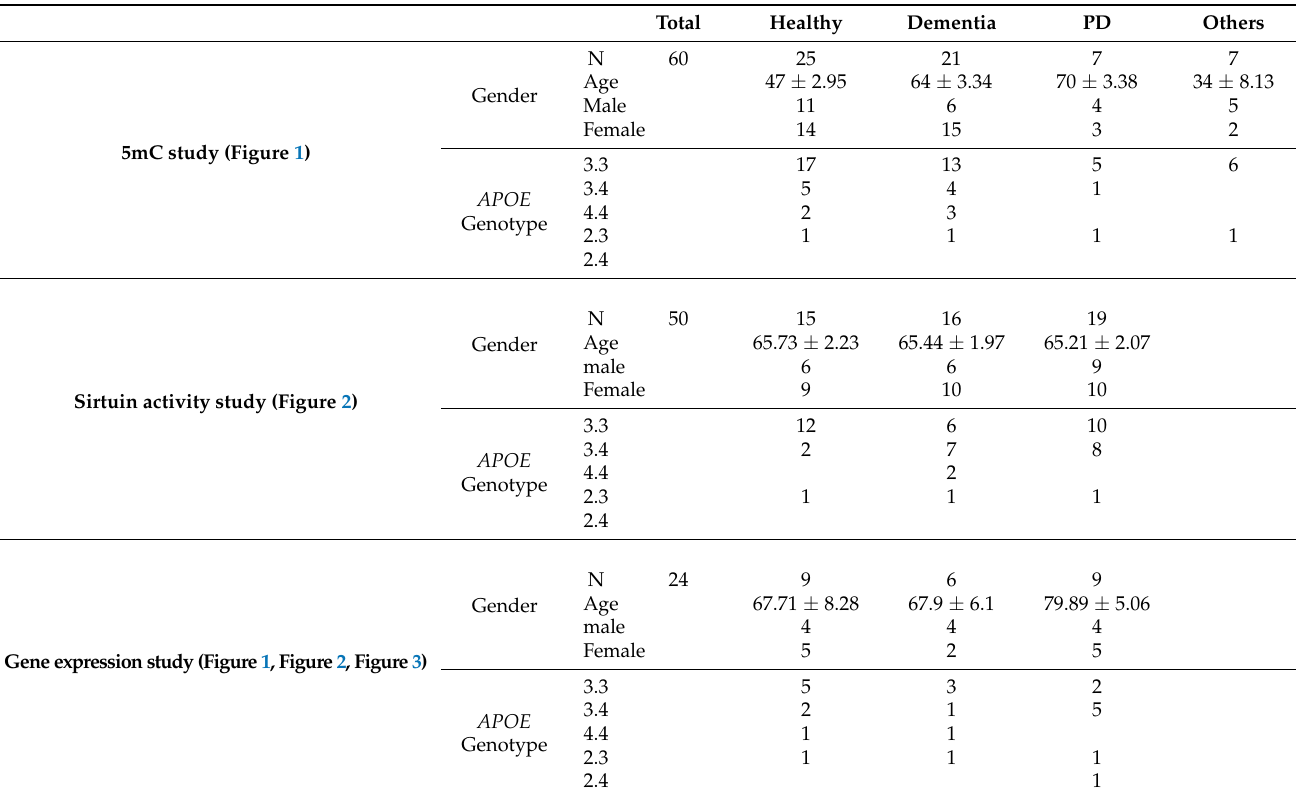
Table 1. Study population demographics and classification of individuals under a range of neurode- generative